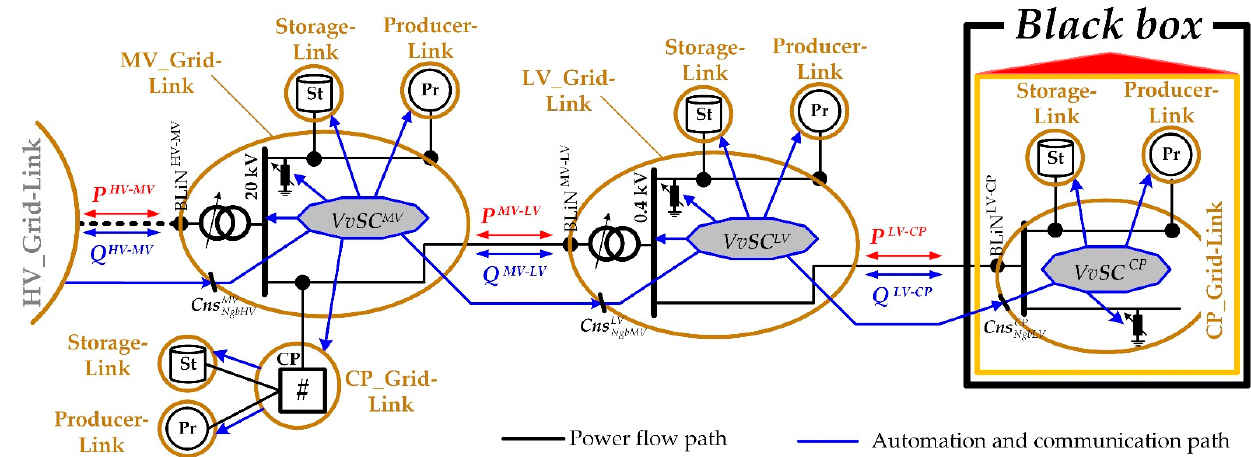
Figure 3. Overview of the generalized vertical Volt/var chain control. Equation (1) compactly represents the control variables and dynamic constraints of the vertical Volt/var chain control, considering the MV, LV, and CP levels. Three Vv SC s are involved that calculate the set-points for the corresponding control variables, which are put in parentheses.